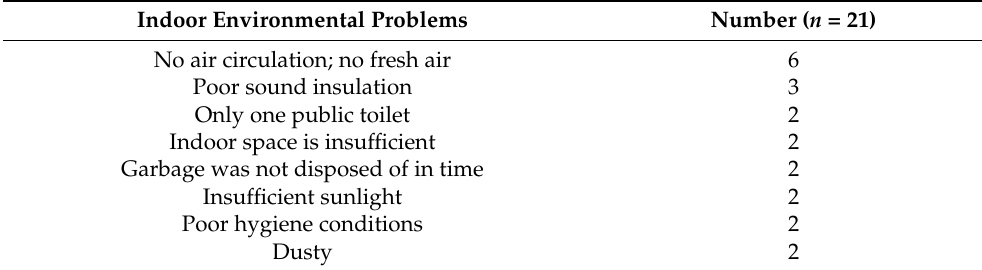
Table 3. Results of the open-ended question survey ( n =